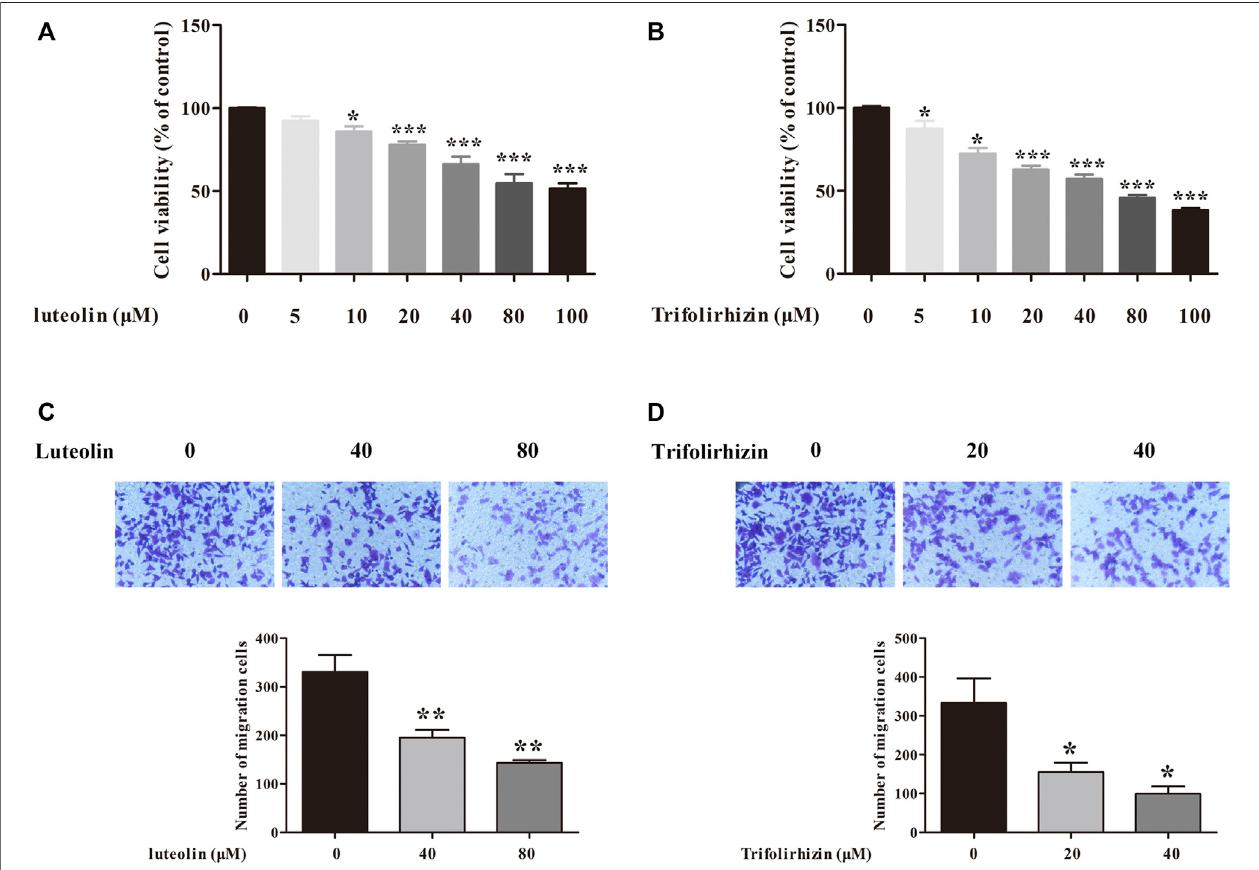
FIGURE 8 | Inhibitory effects of luteolin (A) and trifolirhizin (B) on the proliferation of MCF-7 cells. Inhibitory effects of luteolin (C) and trifolirhizin (D) on migration in MCF-7 cells. Data are represented as mean ± SEM (n (cid:2) 3). * p < 0.05, ** p < 0.01, *** p < 0.001 as compared with that of the control group.